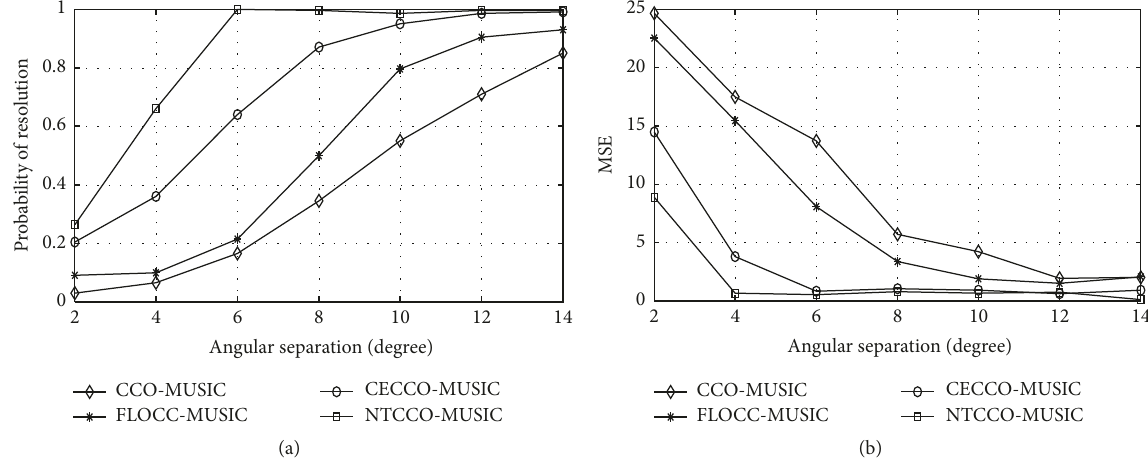
Figure 6: Probability of resolution (a) and MSE (b) versus angular